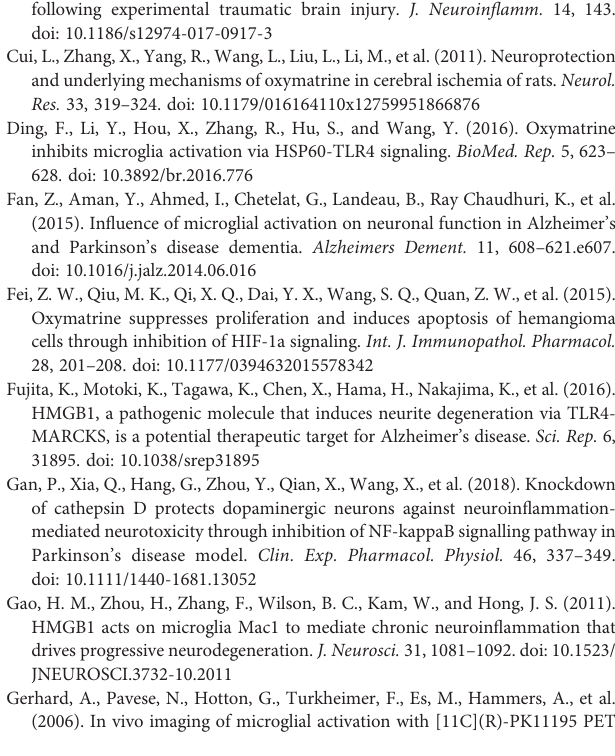
SUPPLEMENTARY FIGURE 1 | The effects of OMT alone on the survival of DA neurons and the activation of microglia. (A) Mice primary DA neurons were treated with 0.2, 1, or 5 m M OMT for 24 h. DAneurons quanti fi cation was determined by TH- immuno fl uorescence staining. Scale bar: 100 m m. (B) Immuno fl uorescence staining for Iba-1 positive microglia in mice primary microglia cells treated with 0.2, 1, or 5 m M OMT for 24 h. Scale bar: 100 m m. The data are presented as mean ±